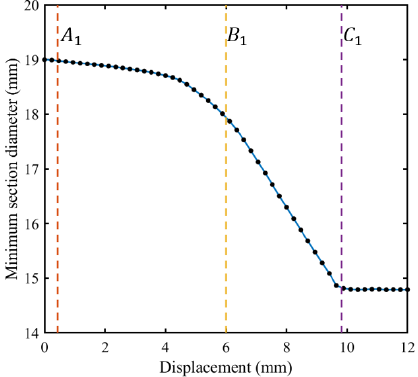
Figure 24. Curve of 𝑑 𝑐 ′ (minimum section diameter) with tensile displacement of VCSB in the FEM-0. Table 7. Comparison of shrinkage (%) of the variable cross-section in FEM-0 and Test 1.